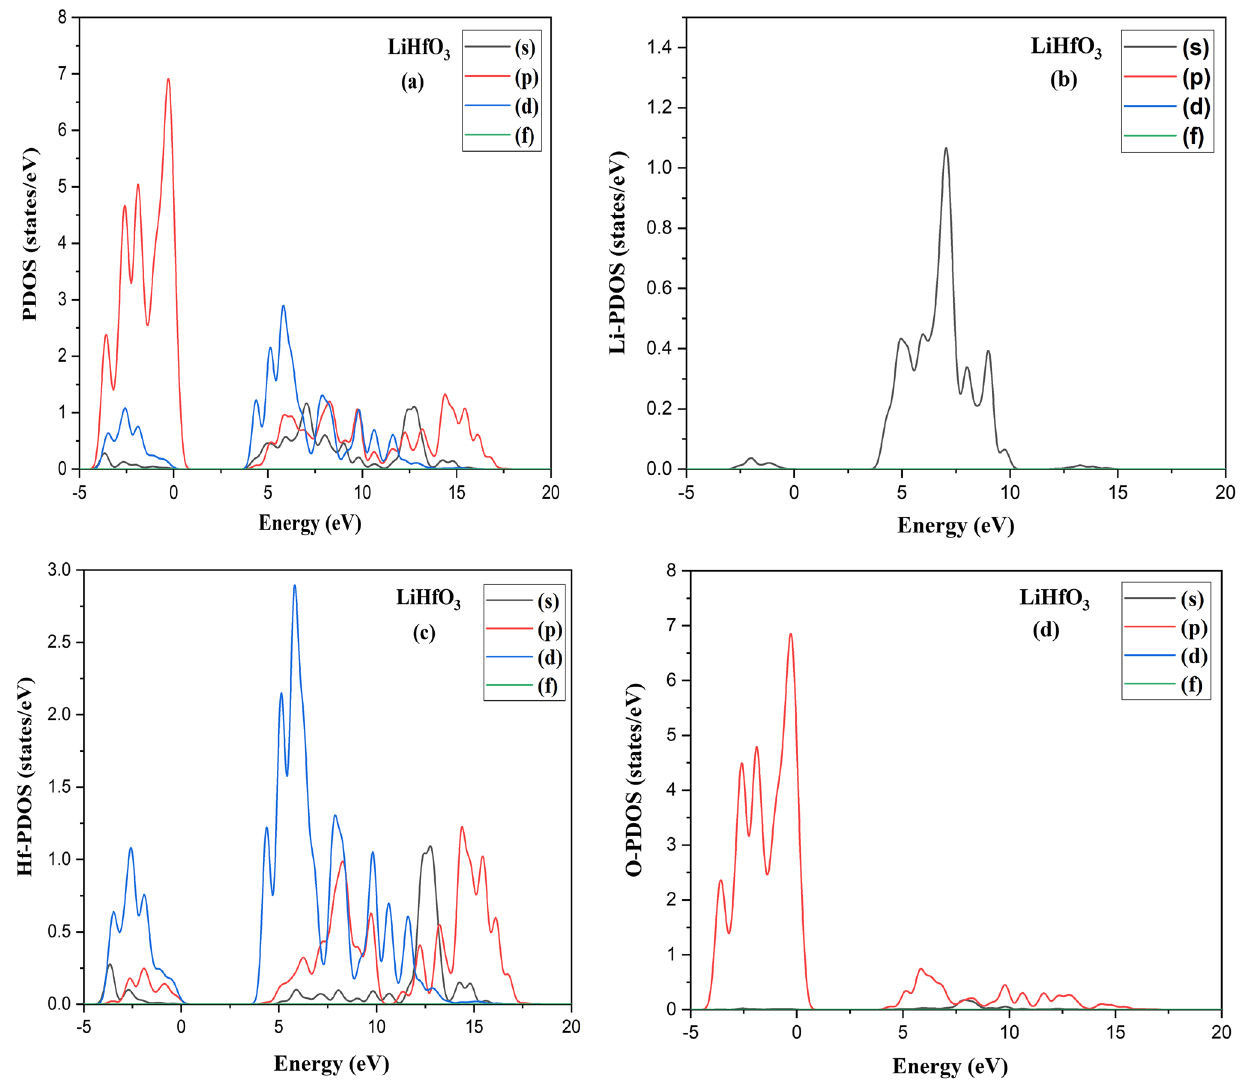
Fig. 6 a Partial DOS b Li-PDOS and c Hf-PDOS, and d O-PDOS LiHfO